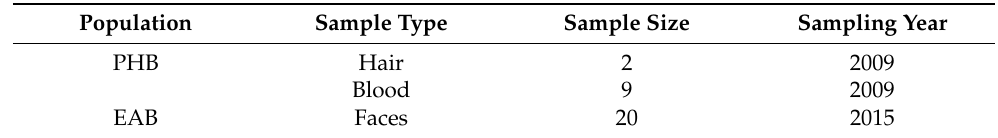
Table 1. Summary information on the samples of Przewalski’s